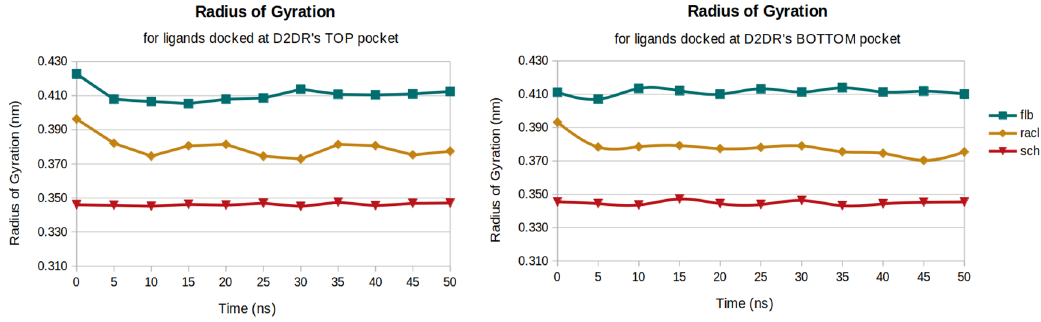
Figure 4. Radius of gyration profiles for the two sets of